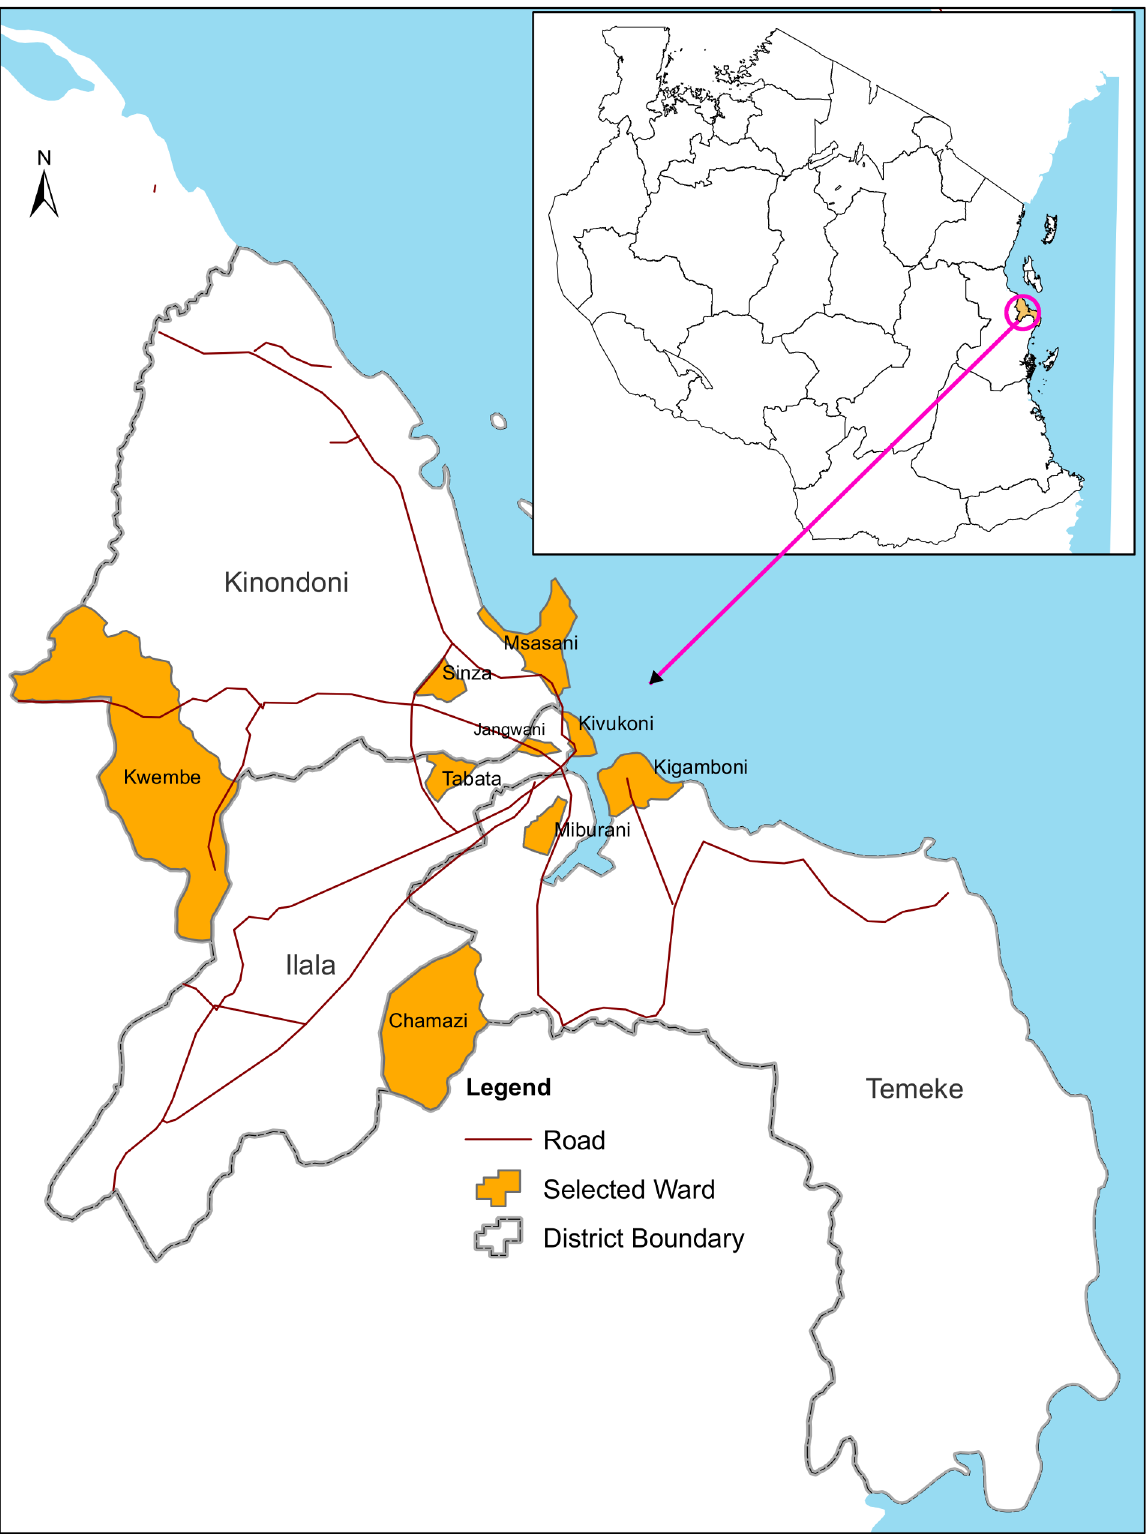
Fig 1. Study districts and sites in Dar es